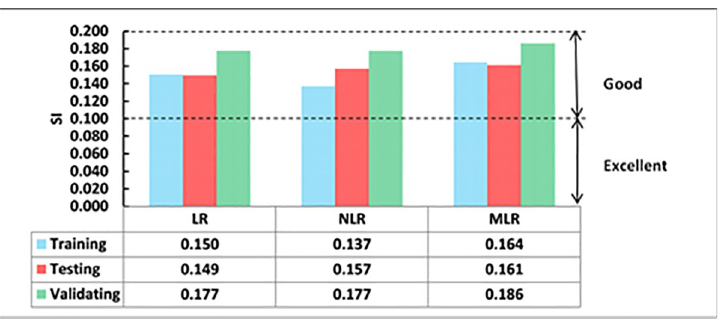
Fig 17. Comparing the SI performance parameter of different developed models.